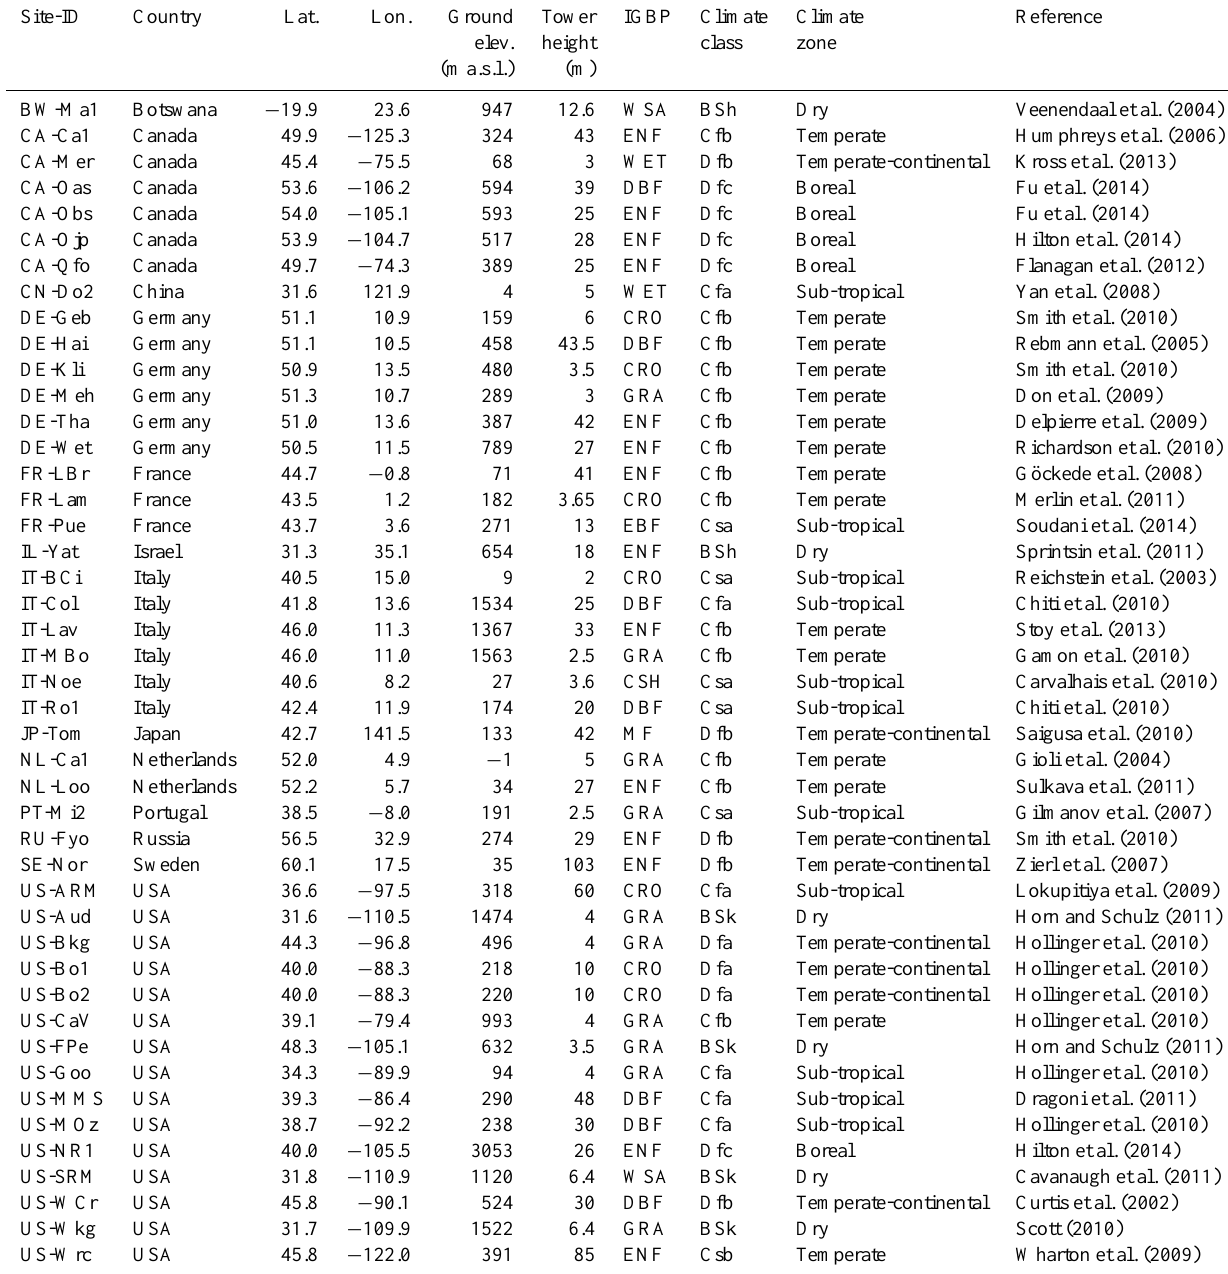
Table A1. Selected eddy-covariance and their attributes. Further details and information on individual tower sites can be found via the FLUXNET data portal